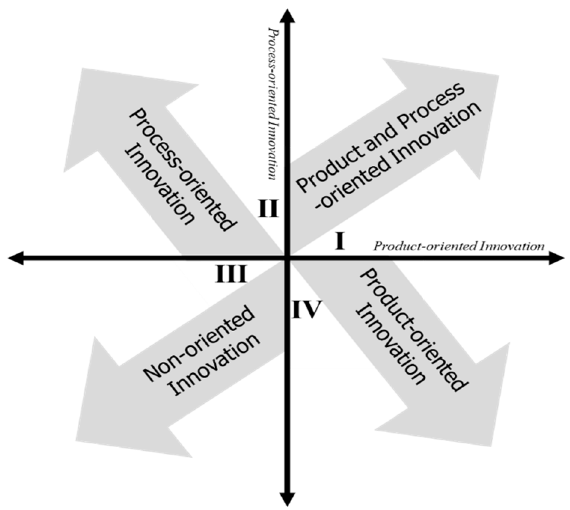
Figure 2. Four innovation types derived from Abernathy and Utterback [1]